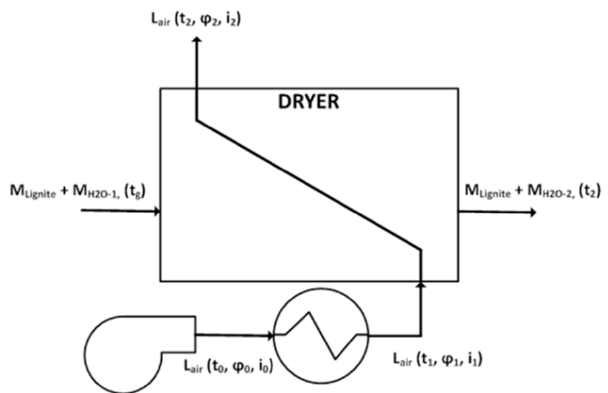
Figure 2. Diagram of a single stage dryer with additional external drying agent heater.